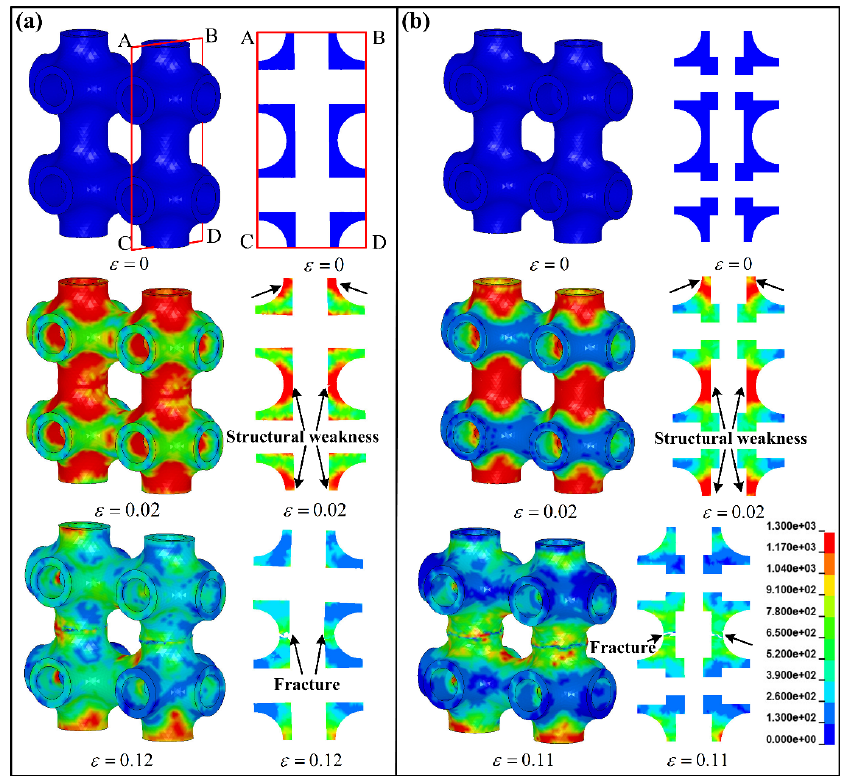
Figure 6. Stress distribution and deformation state predicated by numerical simulation: ( a ) the local cells of specimen HT and ( b ) the local cells of specimen HTSJ.